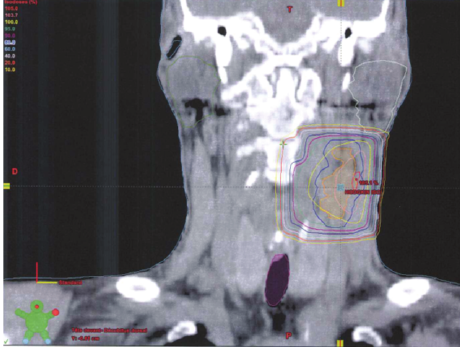
Figure 3: Dose distribution of a three-dimensional conformal radiotherapy: CTV (orange), PTV (blue), and isodoses lines of 105% (red), 100% (yellow), and 95%